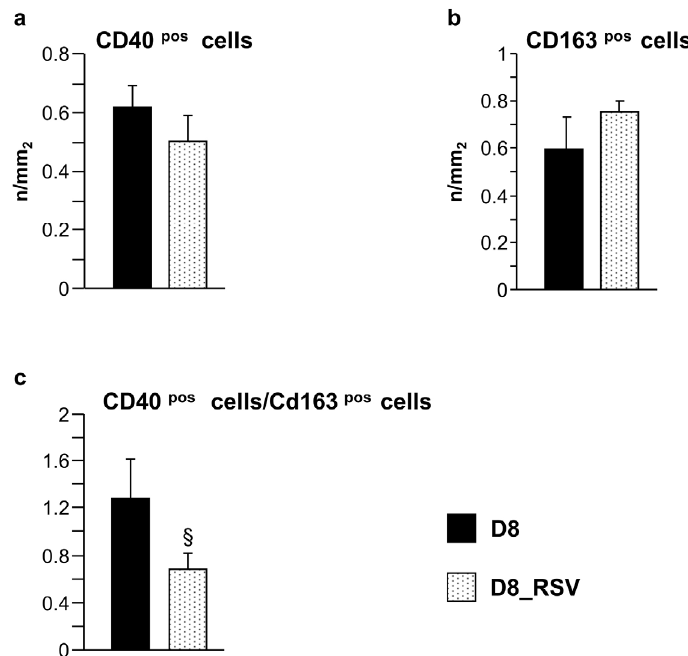
Figure 8. Positive effects of RSV treatment on macrophage recruitment. Mean values ± SEM of CD40pos and CD163 pos cell density ( a , b ), and CD40 pos /CD163 pos cell ratio ( c ), in the LV myocardium of D8 and D8_RSV rats (immunohistochemistry). § p < 0.05, significant differences between D8 and D8_RSV groups (Student’s t ‐ test).